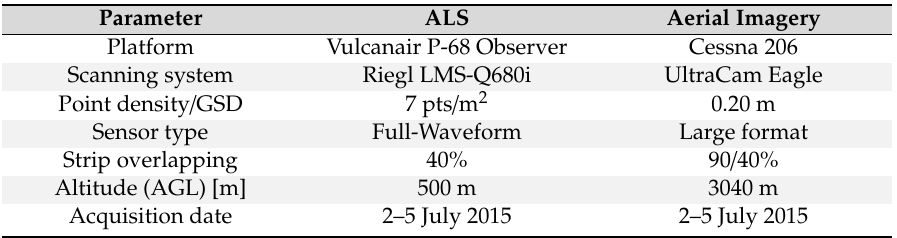
Table 1. Airborne laser scanning (ALS) vs. aerial imagery – comparison of data acquisition parameters.